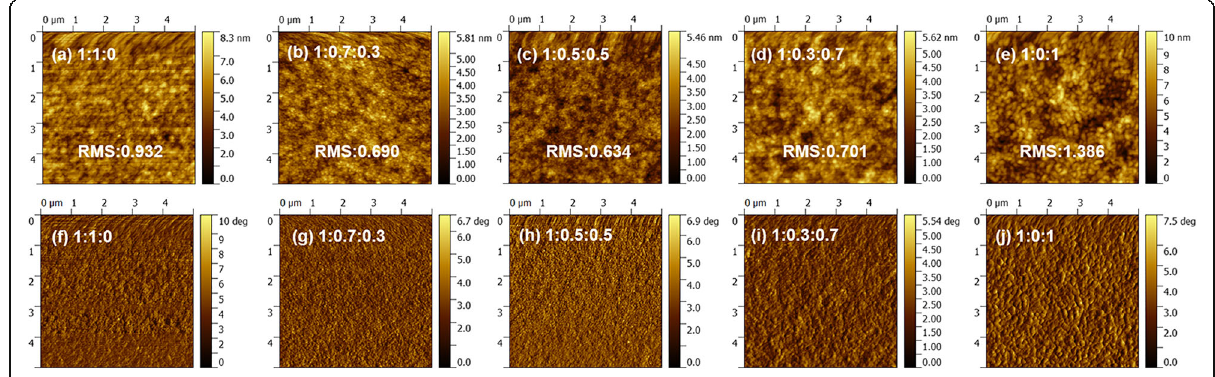
Fig. 4 AFM height images ( a – e ) and phase images ( f – j ) of P3HT:PC 71 BM:ITIC active layers with various